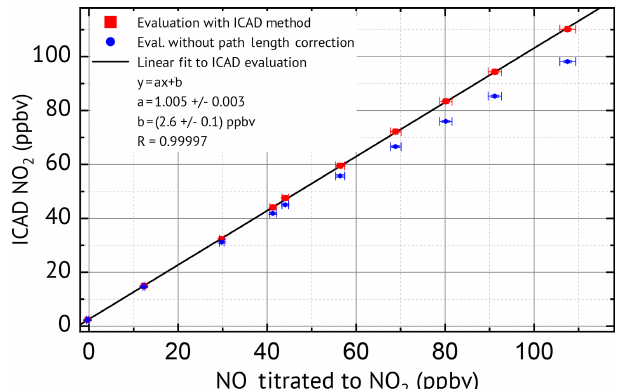
Figure 9. Measurements (spectra recorded with instrument config- uration 1) of gas mixtures with different NO 2